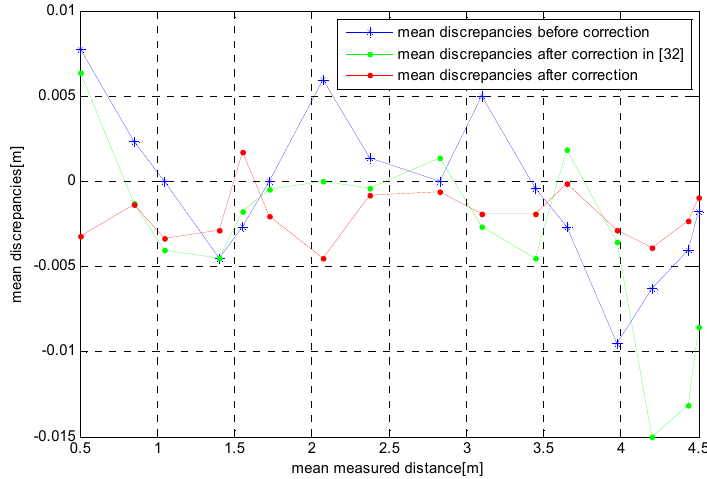
Figure 14. Depth error correction results. Table 2. Analysis of depth error correction results.